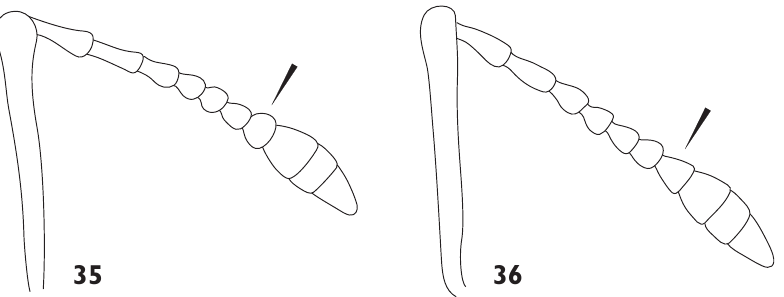
Figures 35–36. Left antenna, anterior view. 35 Austromonticola inflatus , holotype 36 Austromonticola postinventus , holotype. Arrows indicate funicle segment 7. Scale bar = 1